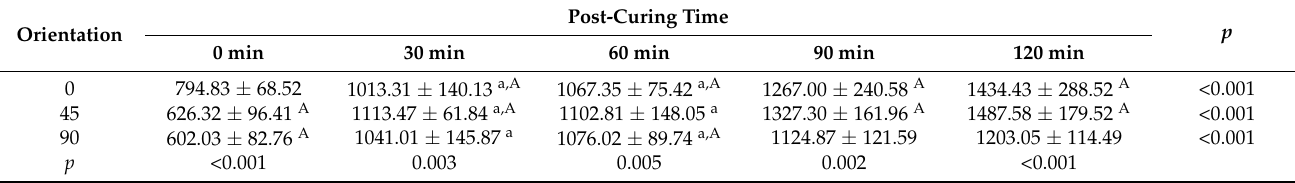
Table 2. Fracture load (N) across the different tested groups for ASIGA